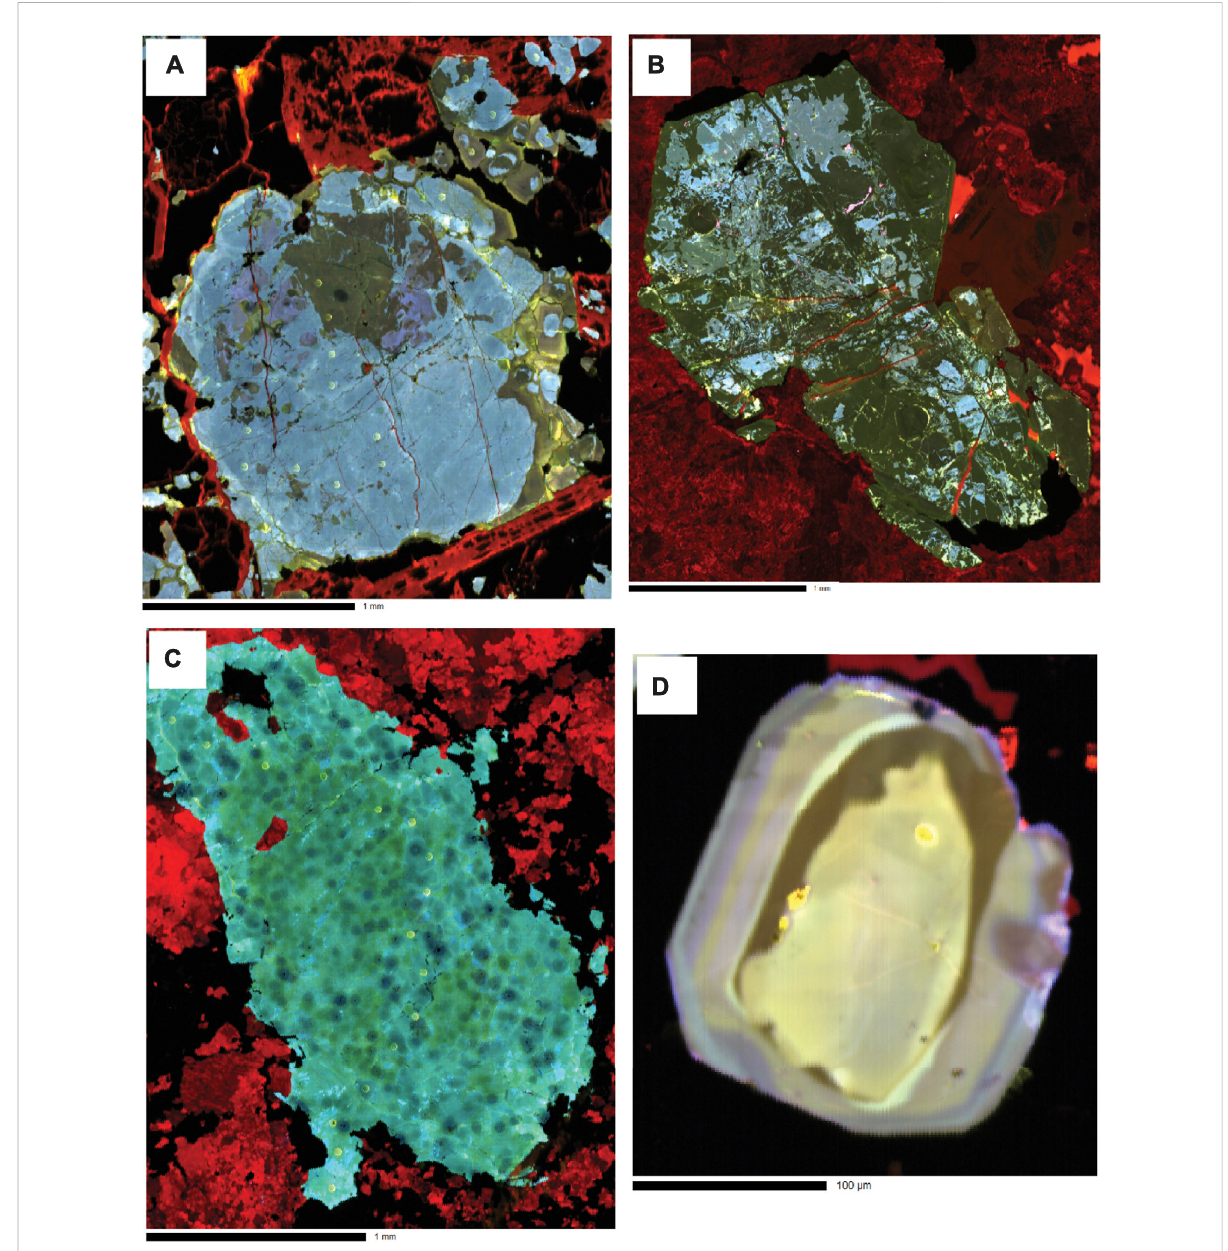
FIGURE 3 Mixed RGB hyperspectral CL images of four apatite grains from the Ernest Henry area. Images are arranged according to the sample ’ s location from the deposit, starting with the most distal sample. (A) MMA2-122.75. (B) EHMT1-1479.1. (C) EHM-005. (D)